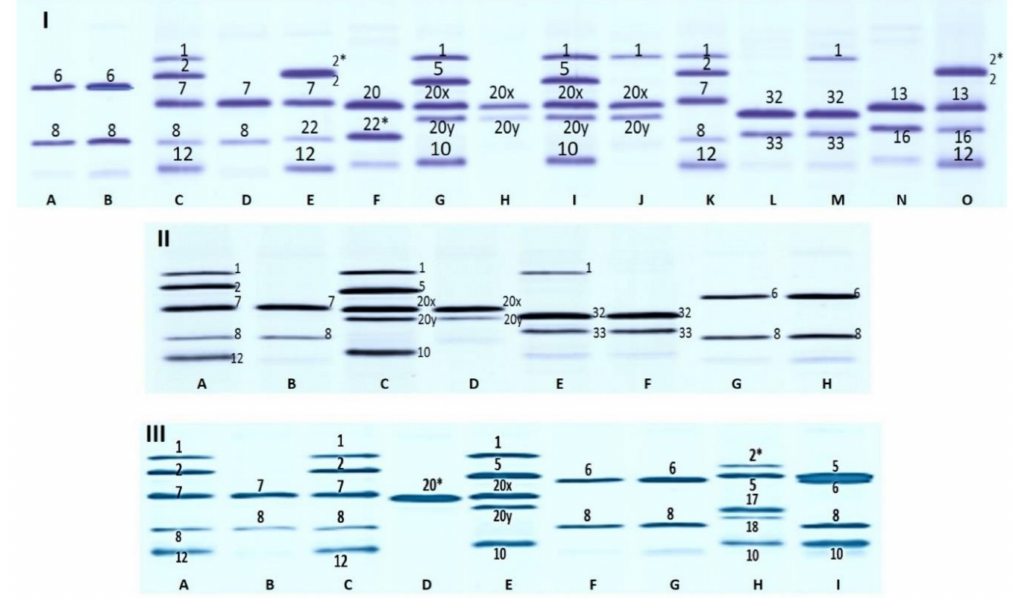
Figure 1. HMW-GS composition observed in a durum wheat collection. I , Moroccan landraces.